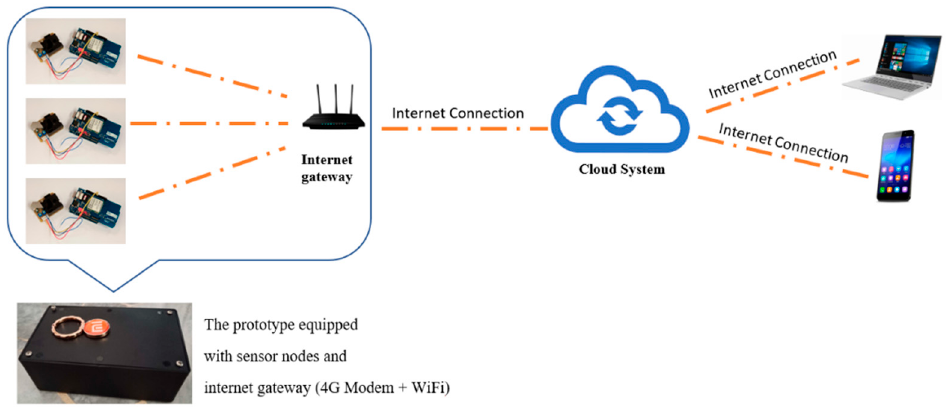
Figure 9. Cloud system used by the prototype.